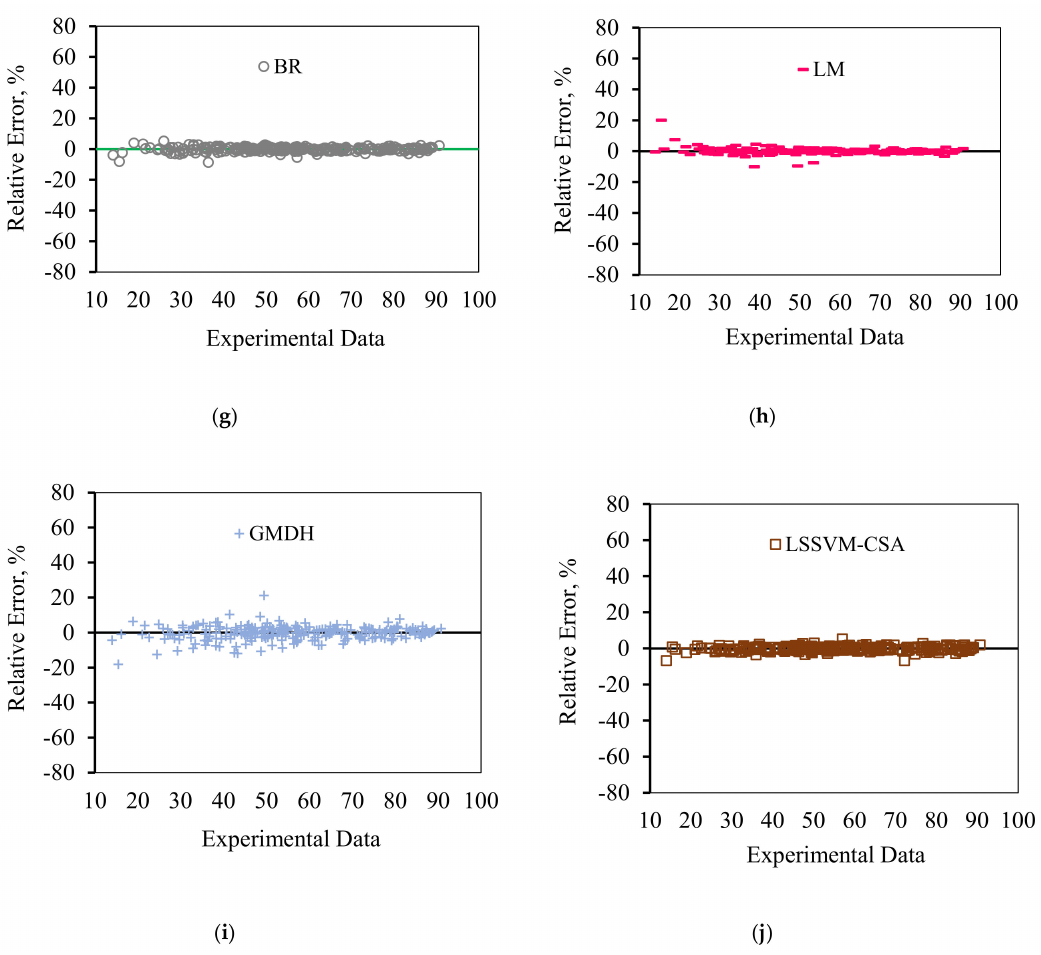
Figure 9. Error distribution for the proposed asphaltenes adsorption models versus experimental